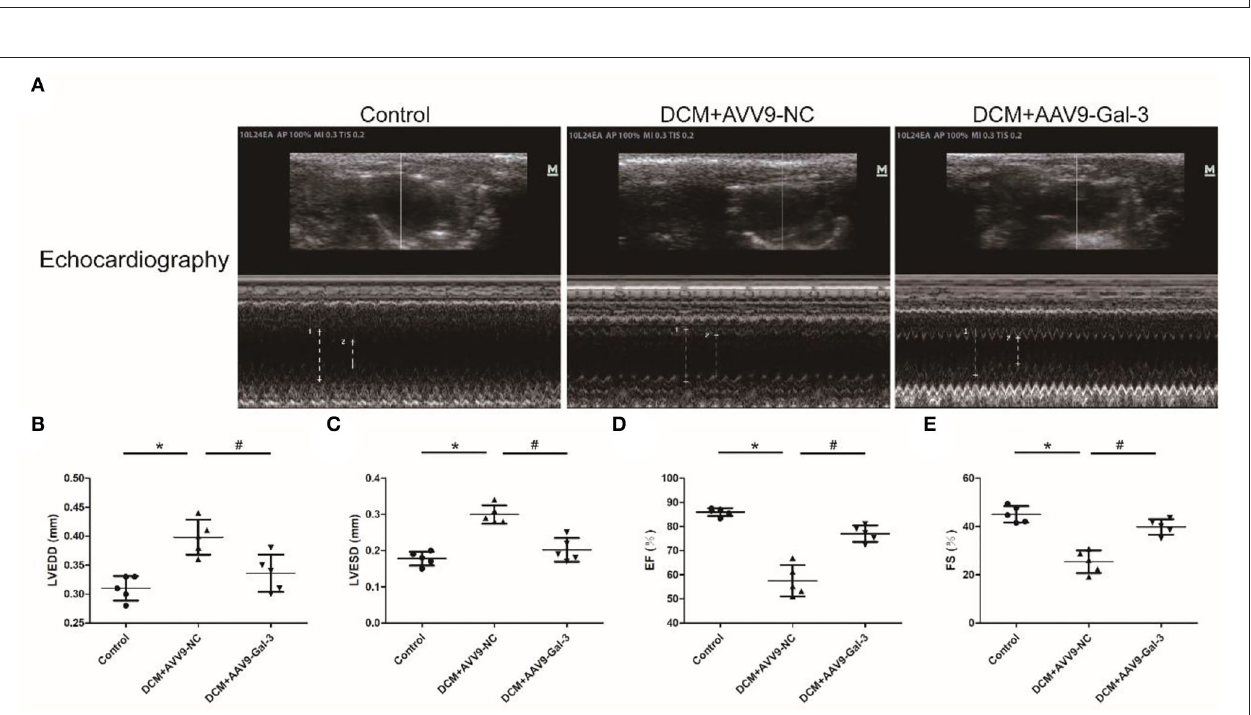
FIGURE 2 | Gal-3 inhibition reversed diabetes-induced cardiac dysfunction (A–E) echocardiographic measurement of cardiac structure and function. Data are shown as mean ± SD. n = 5, * P < 0.05 vs. Control; # P < 0.05 vs. DCM + AAV9-NC.